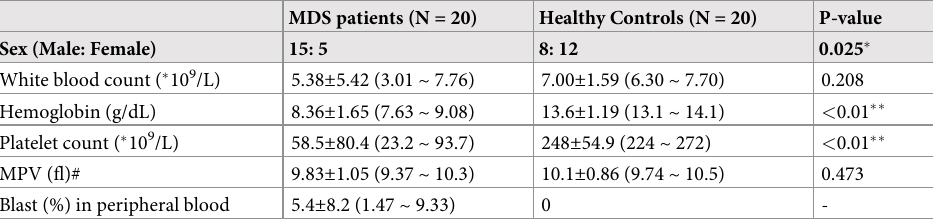
Table 1. Lab data for MDS patients and healthy